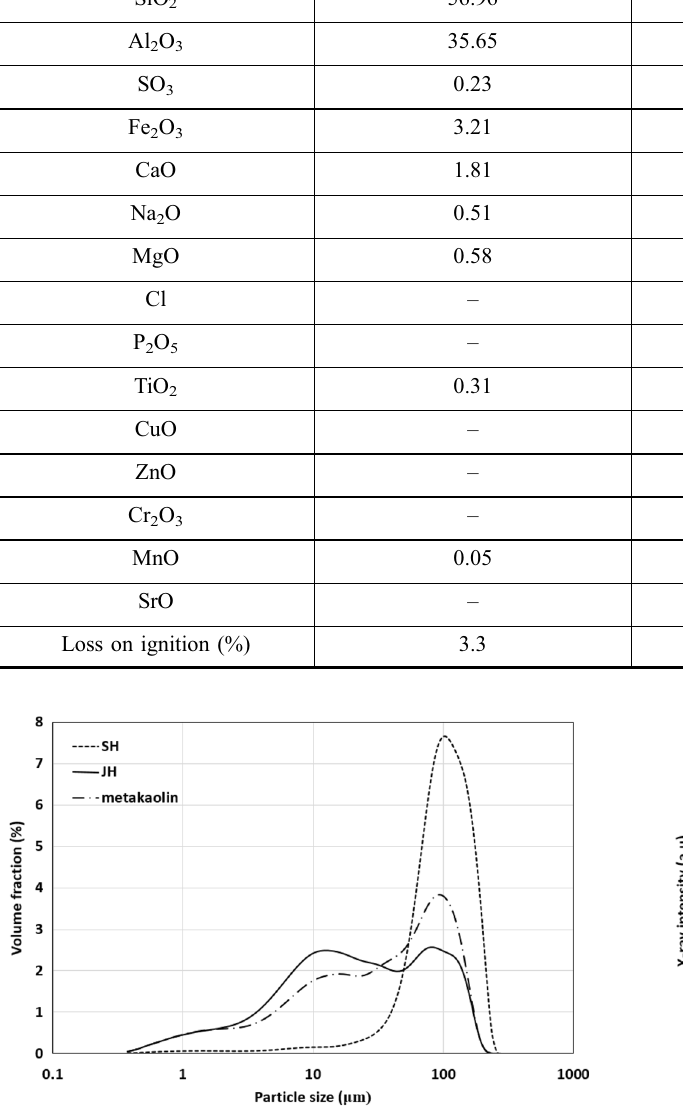
Fig. 2 XRD patterns of